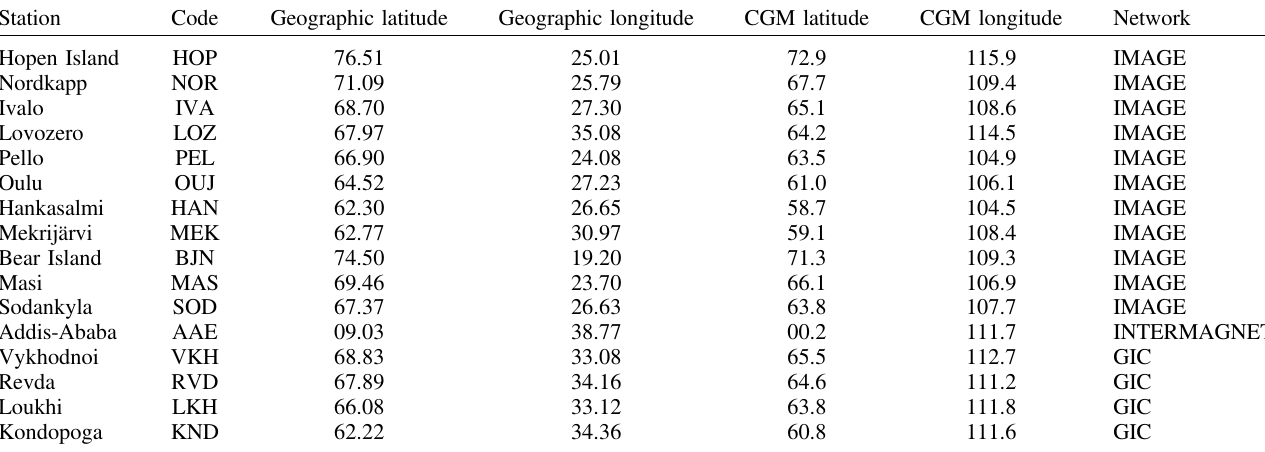
Table 1. Magnetic and GIC